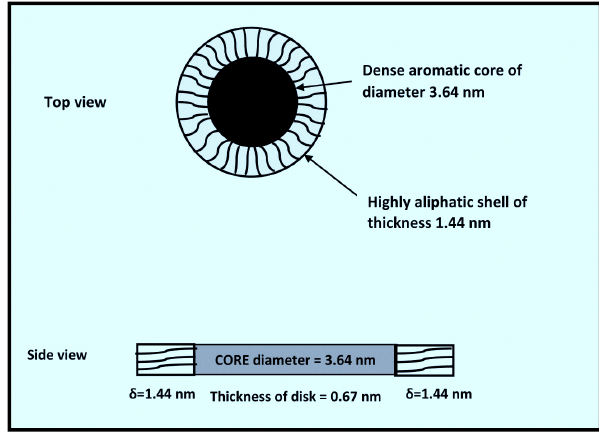
Figure 3. Size and structure of asphaltene nanoaggregate.